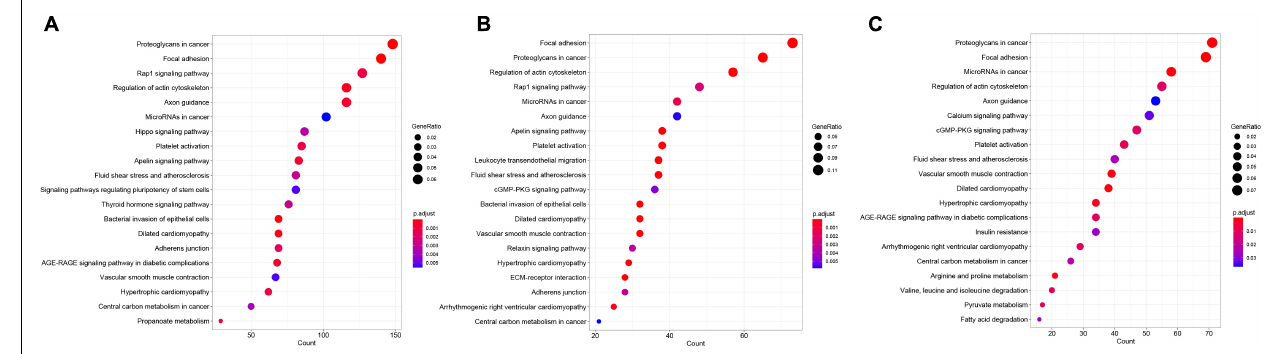
FIGURE 5 | KEGG enrichment results of down-regulated DEGs at different low temperatures. (A–C) Represented KEGG enrichment results at 13, 15, and 17 ◦ C, respectively.